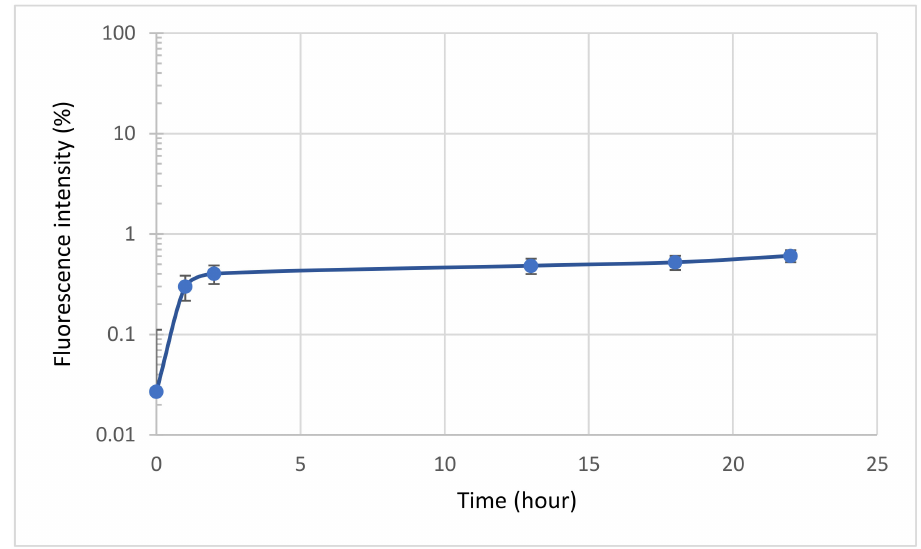
Figure 6. Bacteriophage release from polyelectrolyte microcapsules depending on the incubation